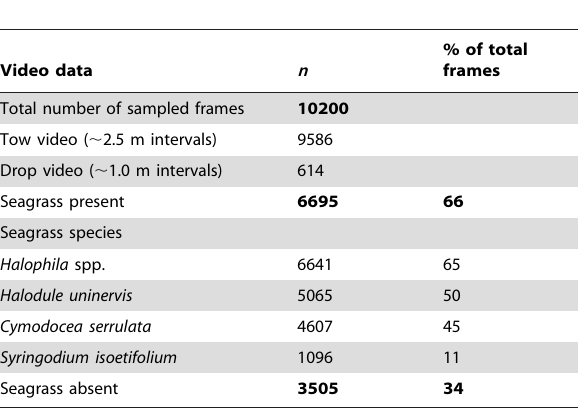
Table 1. Total number of frames obtained from tow and drop video, counts ( n ) and percentages (%) of frames with and without seagrass, and breakdown by